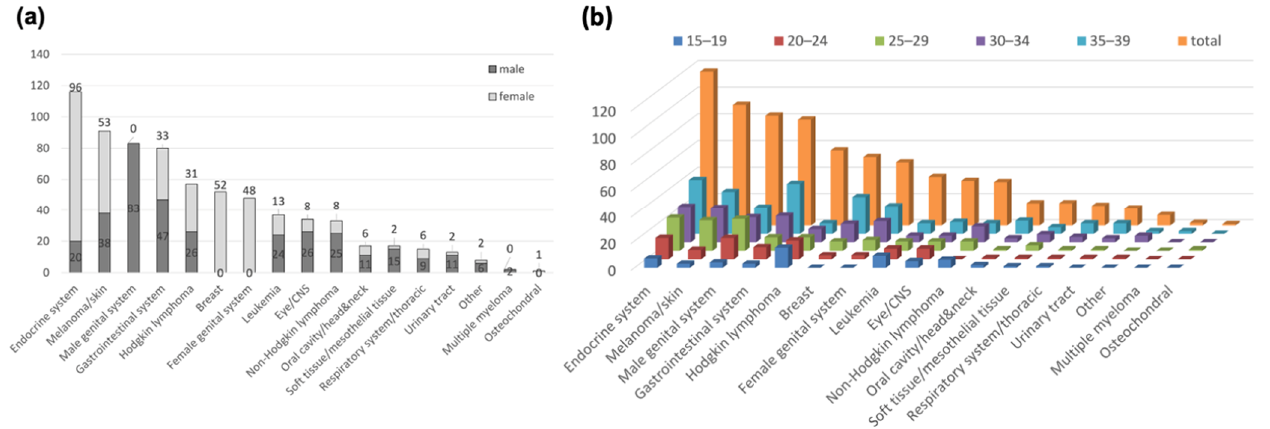
Figure 3. The distribution of the most frequent cancers in the Augsburg Tumor Data Management of the Comprehensive Cancer Center Augsburg from 2014 to 2018 among 15- to 39-year olds according to gender ( a ) and by 5-year age intervals ( b ) are shown in the bar charts.